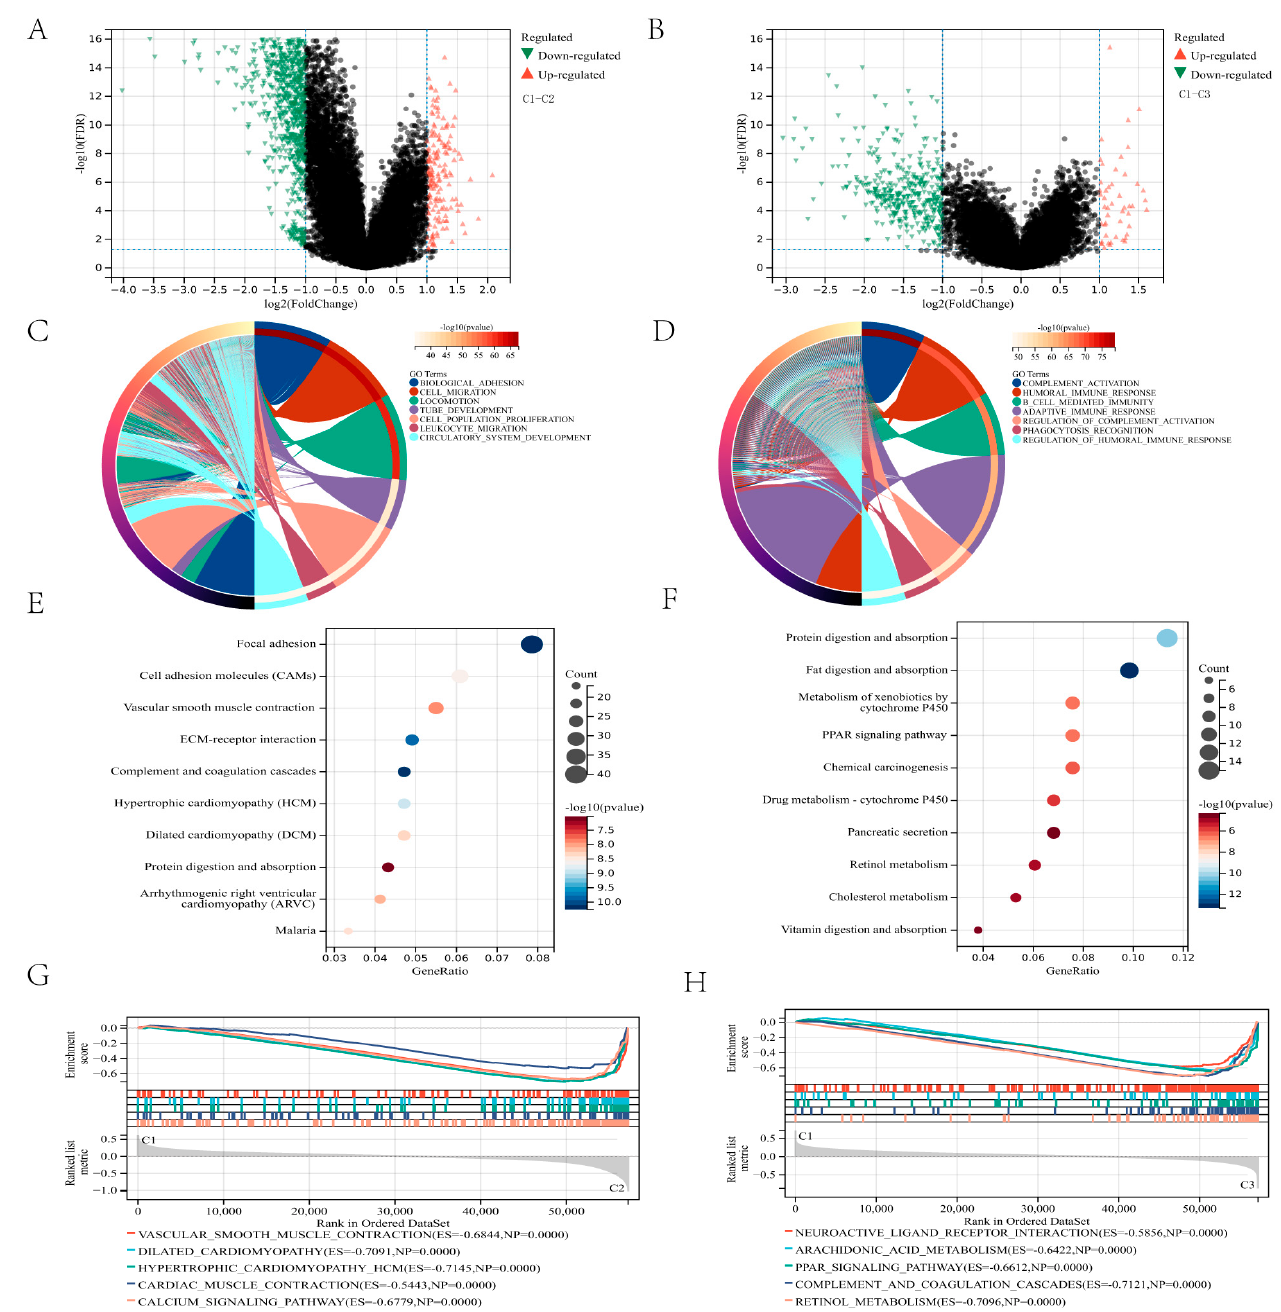
Figure 4. DEGs and functional enrichment analysis: ( A , B ) The volcano plot shows the DEGs between the two groups. ( C , D ) The circle plot illustrates the two groups’ biological processes enriched by GO analysis. ( E , F ) Bubble diagram illustrating the signaling pathways enriched by KEGG analysis between the two groups. ( G , H ) Plots visualize the results enriched by GSEA between the two groups.